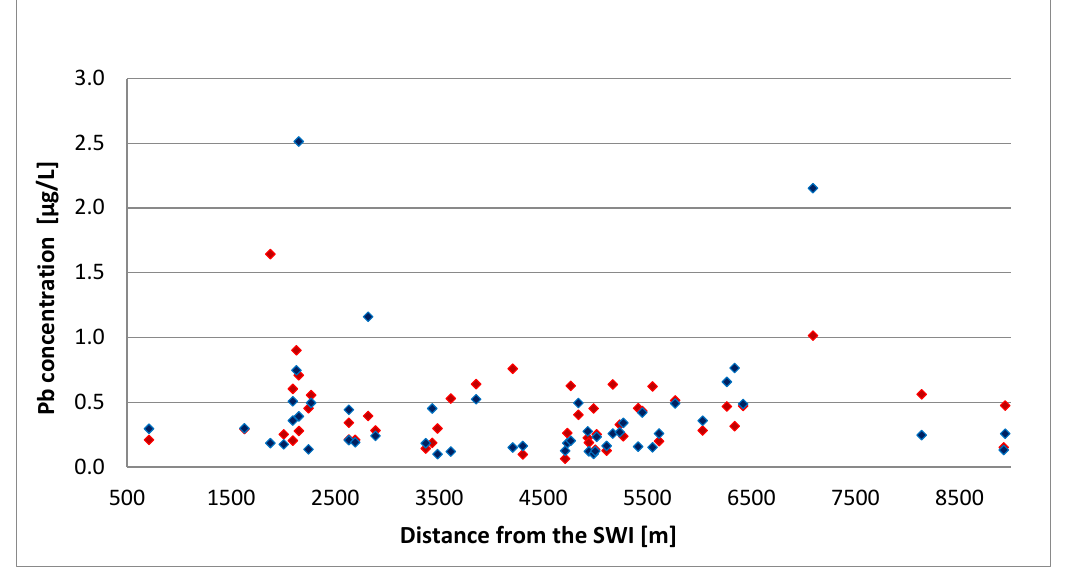
Figure 14. Pb urinary concentrations estimated by MERLIN software (red dots) and measured concentrations reported in the Human Bio-monitoring study (blue dots) related to the subject residence distance from the SWI.